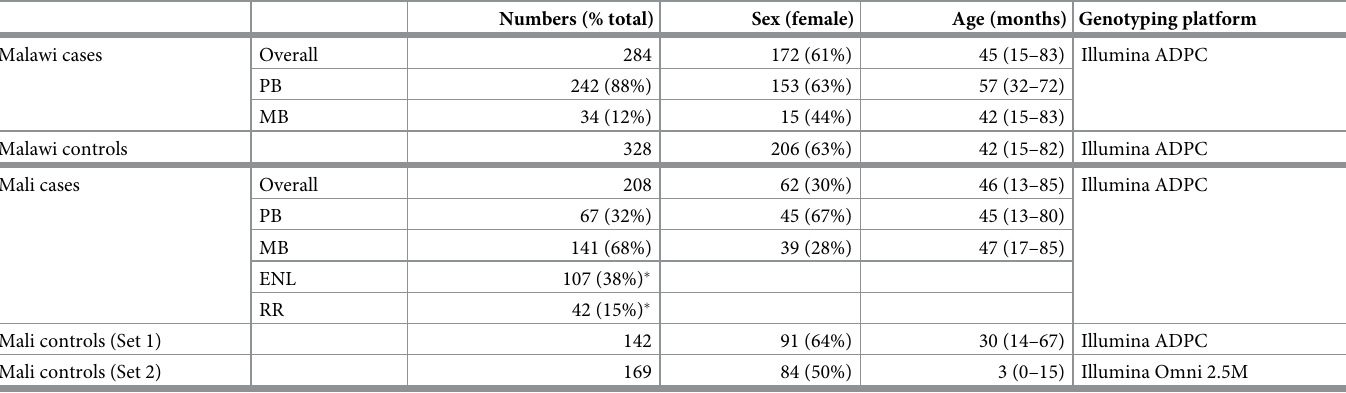
Table 1. Demographics & clinical characteristics of study